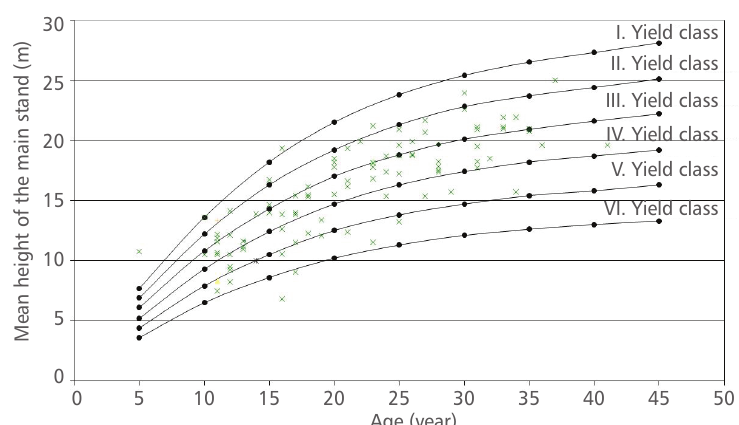
FIGURe 2. Standard deviation of height growth plotted against the age and the mean height of the main stand (Yield classes: Hungarian national yield tables [26,